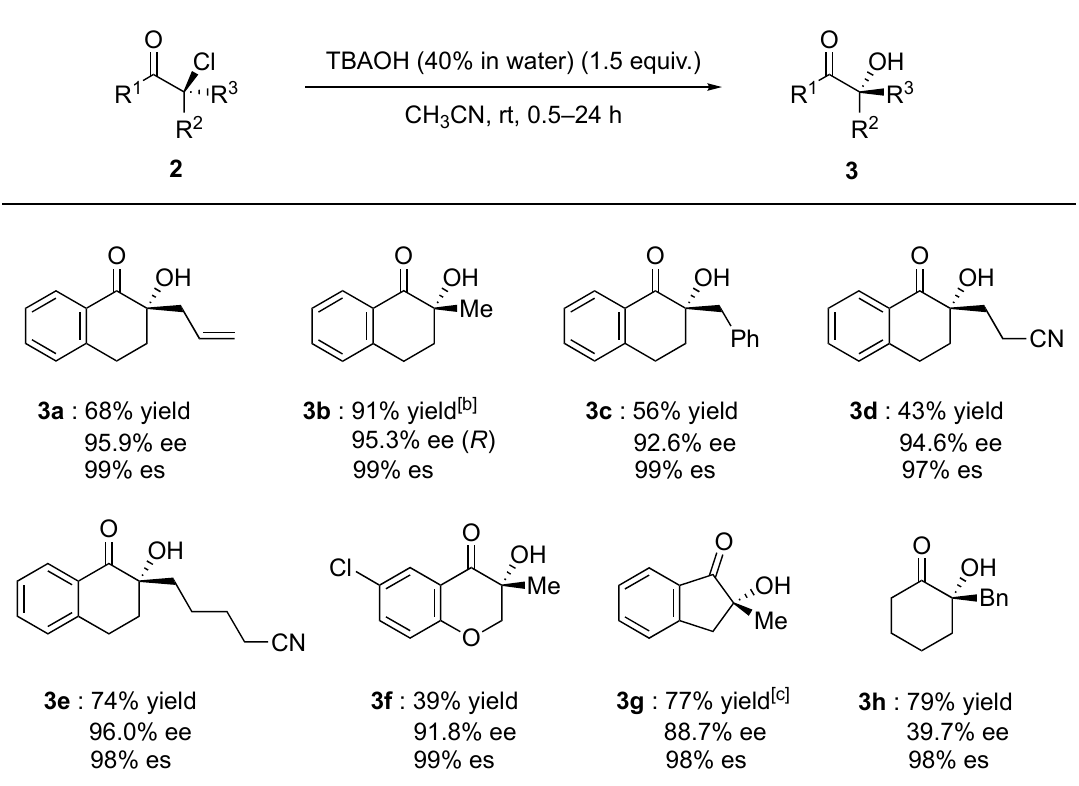
Figure 2. Substrate scope [a] ( [a] Reactions were carried out with 1.5 equiv. of TBAOH at ambient temperature in acetnitrile, unless otherwise noted. [b] Reaction was carried out at 0 °C. [c] Reaction was carried out with 3.0 equiv. of TBAOH at 0 °C. es: enantiospecificity).